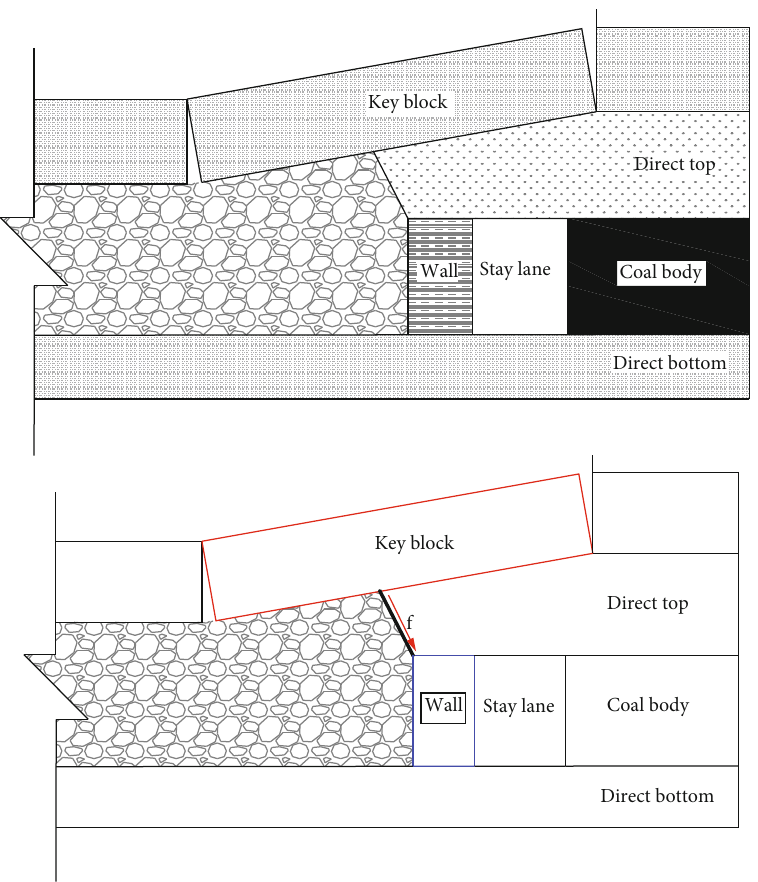
Figure 3: Schematic diagram of the movement status of the roof plate along the empty lane.